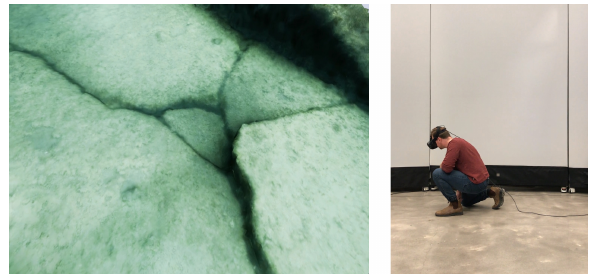
Figure 12. VH Experience: The Digital Restitution of Lot